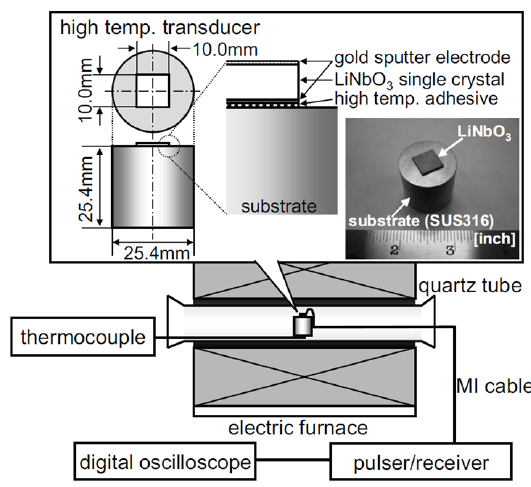
Figure 12. Schematic diagram of an experimental setup for high-temperature ultrasound transducer [84] (copyright 2010 by the American Institute of Physics).